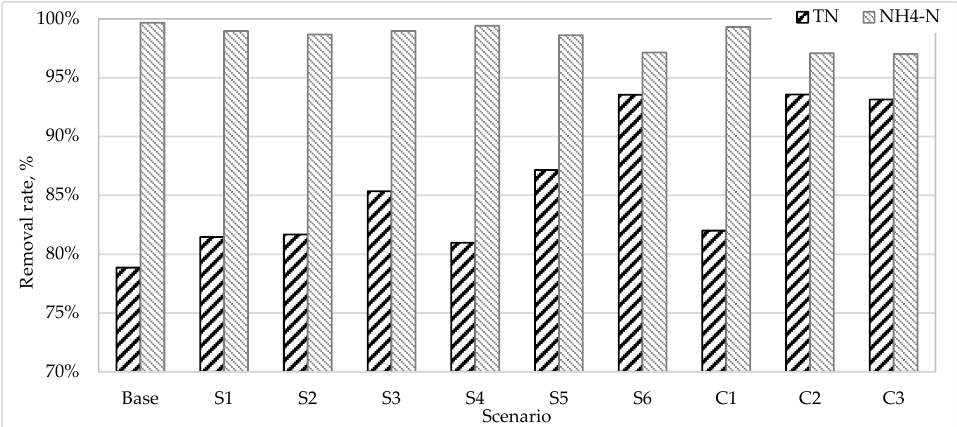
Figure 10. Average removal rates of TN and NH 4 -N in different scenarios.